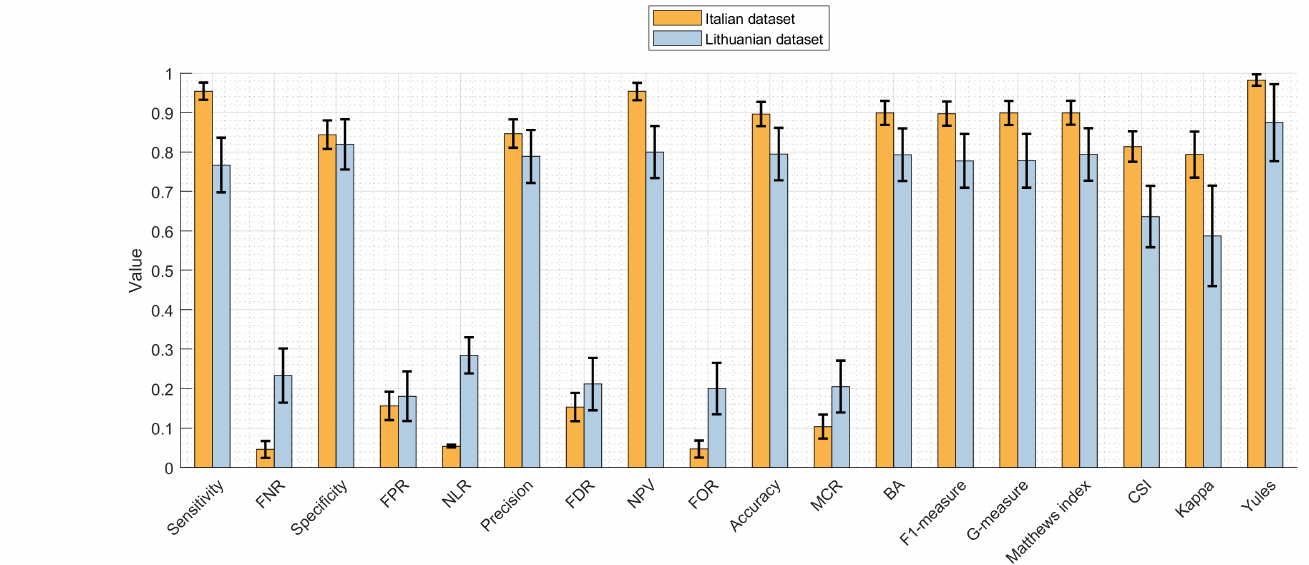
Figure 11. Summary of the performance